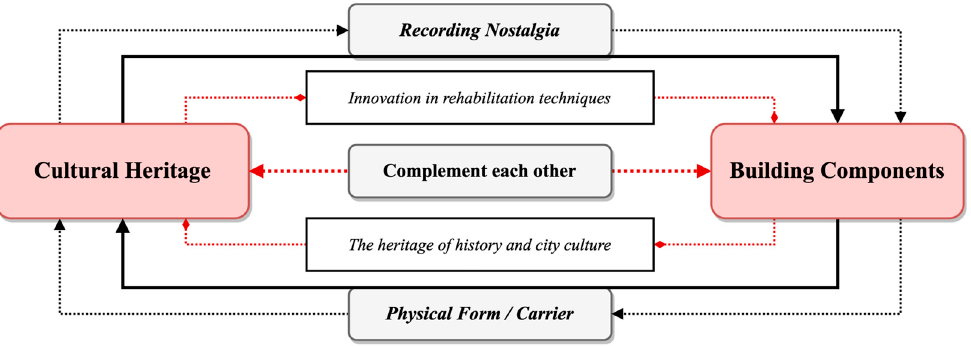
Figure 6. Two aspects of assessing the validity of traditional architectural heritage.